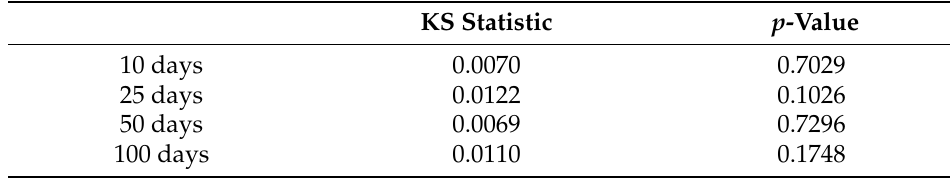
Table 1. KS test for distributions of simulated sample